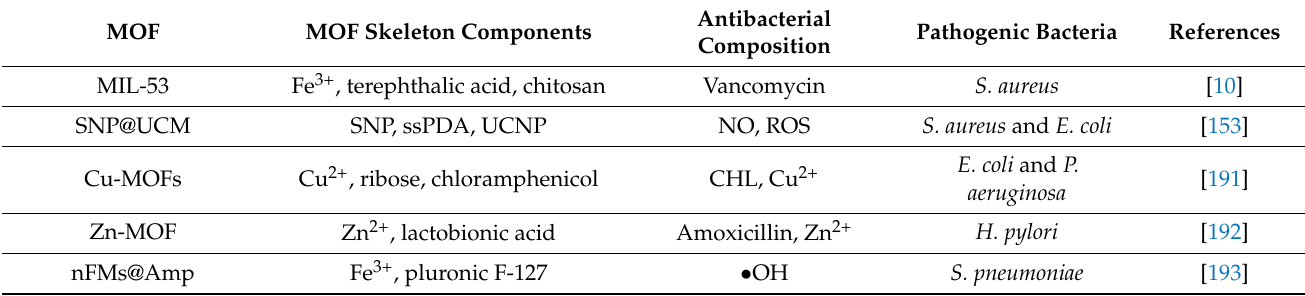
Table 3. MOFs in antibacterial